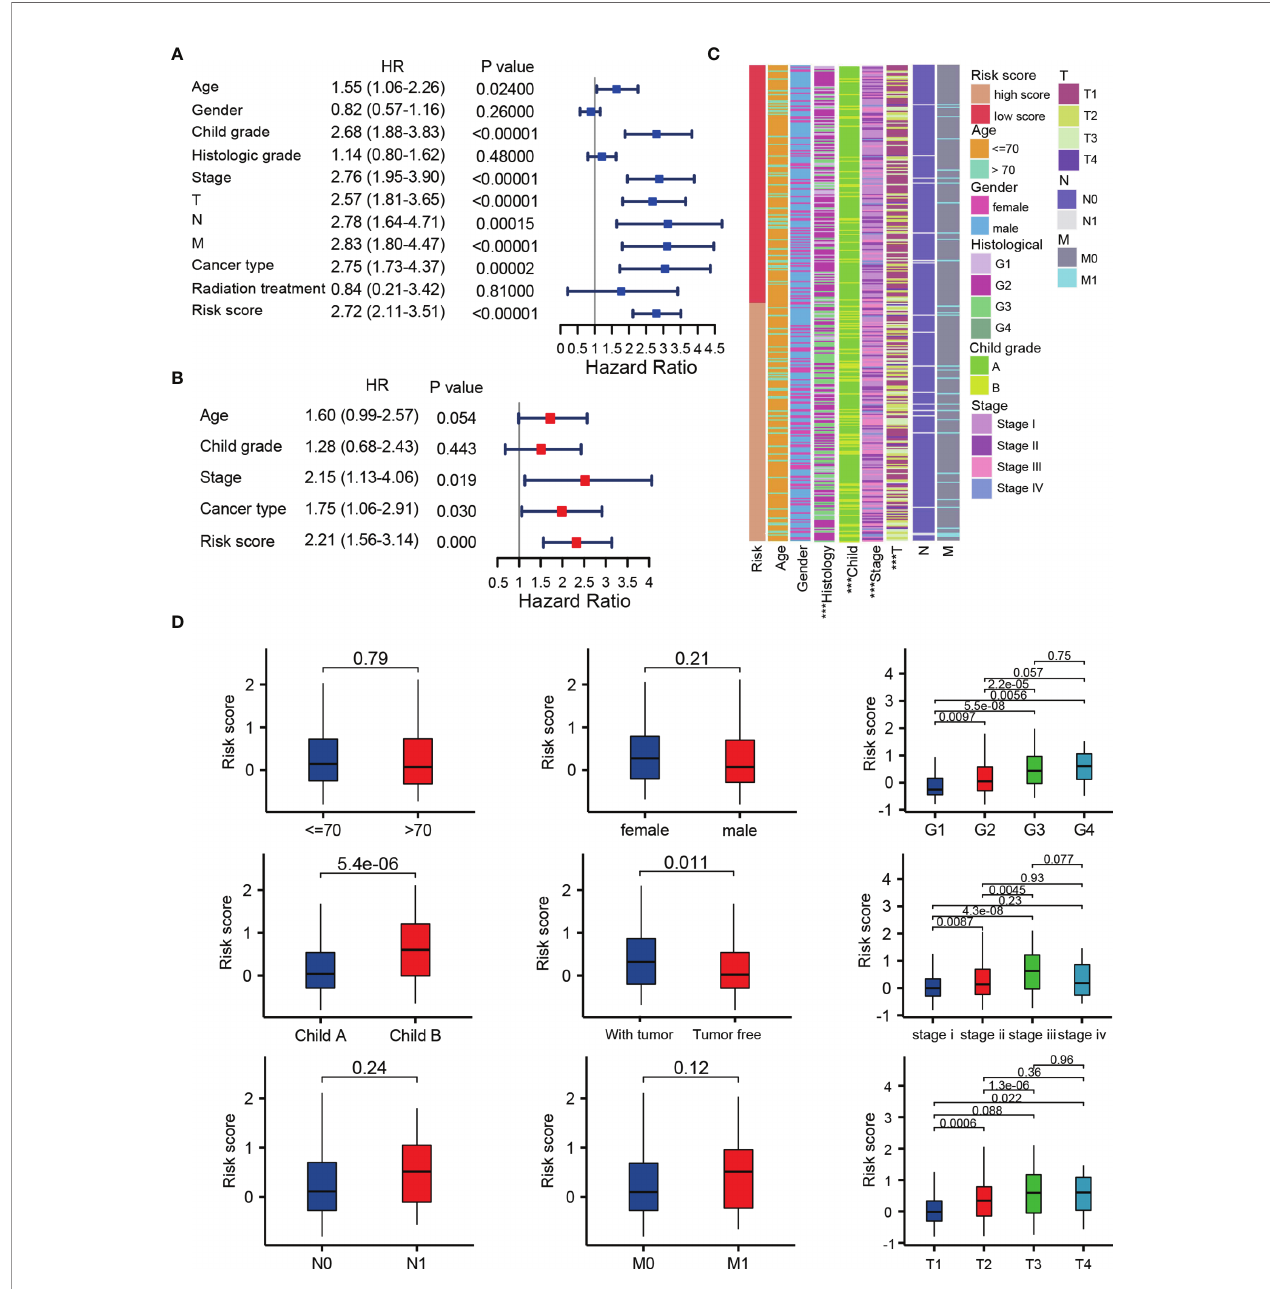
FIGURE 6 | Integration analysis of the TRP score and other clinical factors. (A, B) Cox regression analysis of clinical parameters in the whole set. (C, D) Correlation of the risk score with different clinical characters *** p <